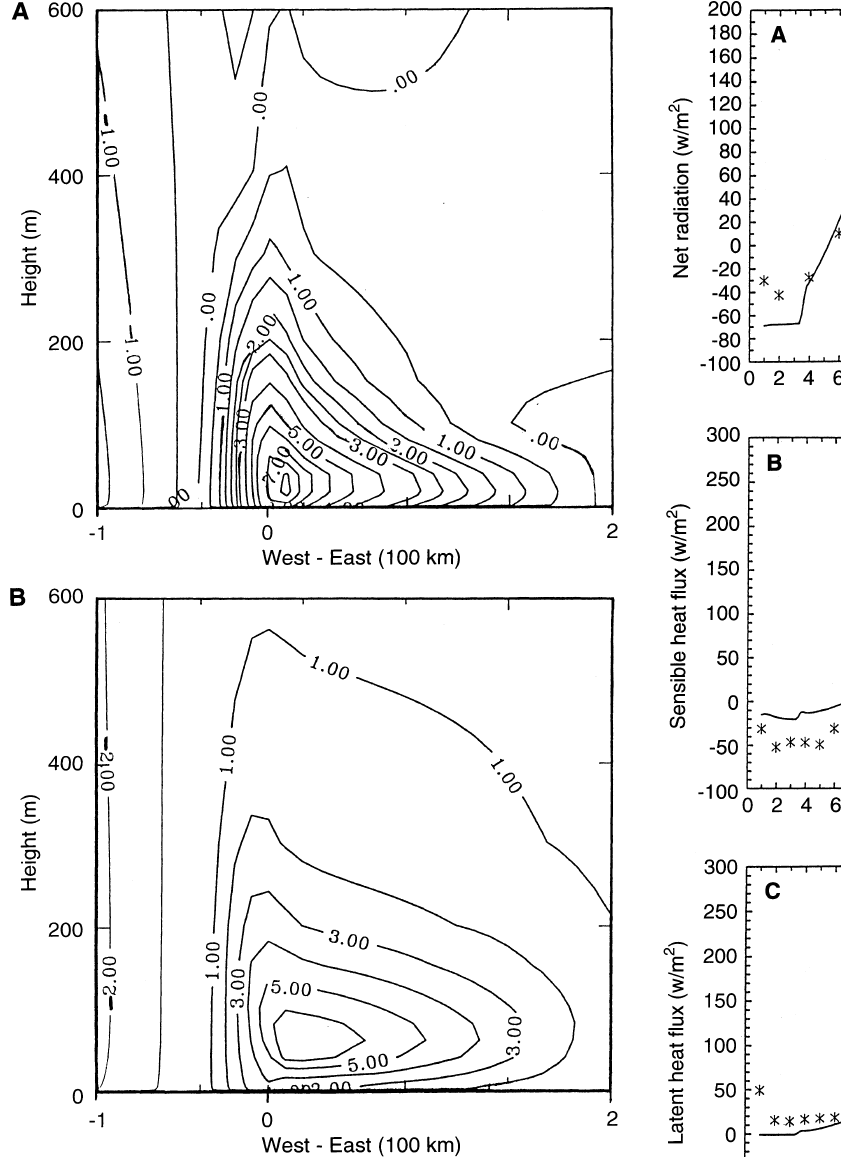
Fig. 6A,B. Wind components computed near the ice edge ( ) 100 km from ice edge to 150 km over the ice cap), on July 12 at 1800 LST, A the east-west component u and the B north-south component v . Notice that the topography has been suppressed from the graphics